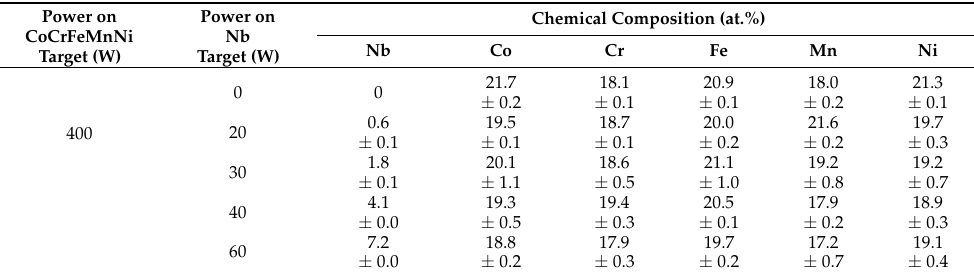
Table 1. Chemical compositions of Nb x -CoCrFeMnNi HEAFs with different powers applied on the Nb